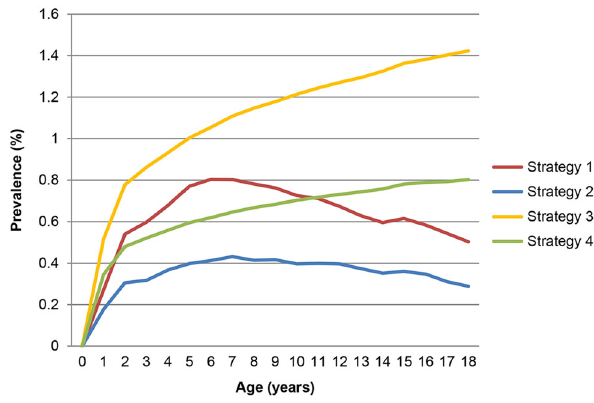
Fig. 2 Prevalence by age for atopic asthma